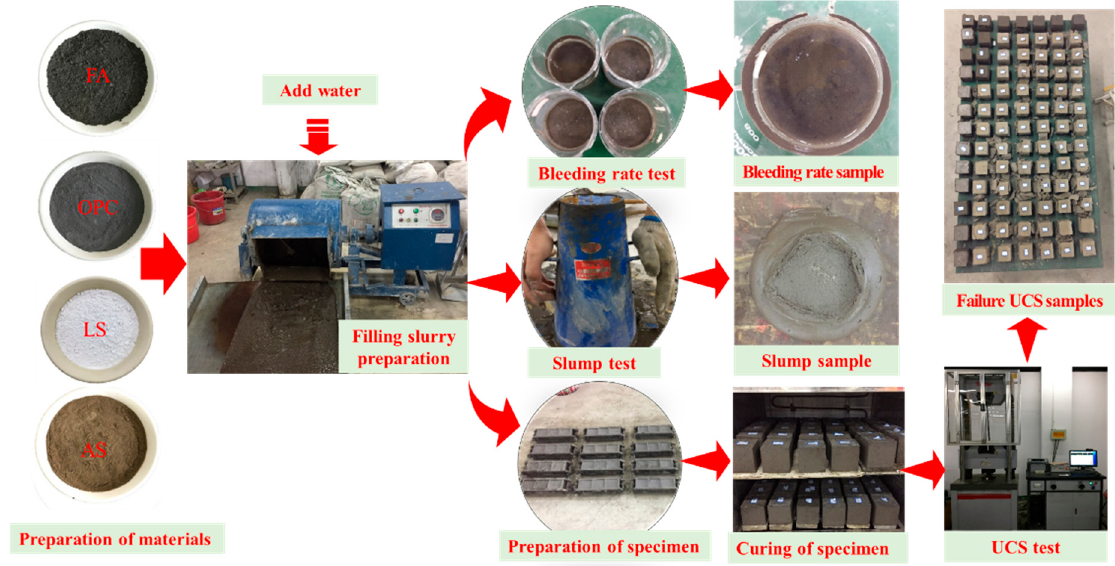
Figure 7. The process of cemented filling material preparation and testing. OPC—Ordinary Portland cement; LS—Lime–slag; UCS—Uniaxial compressive strength.